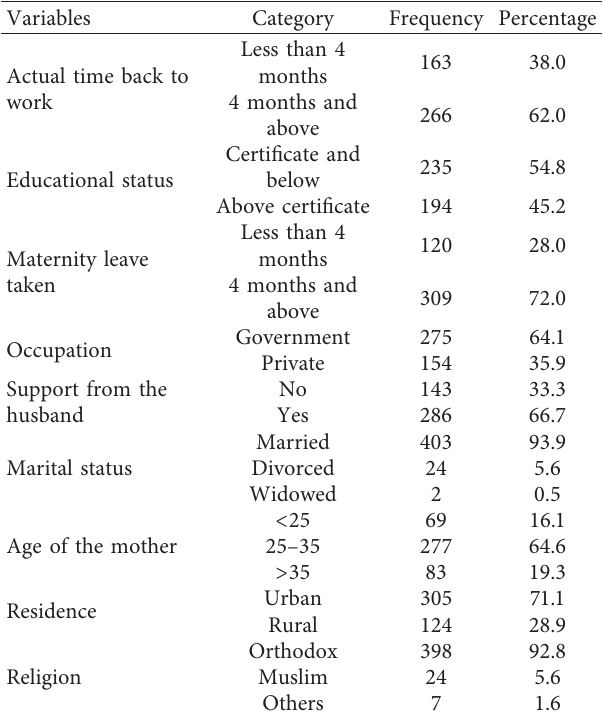
Table 1: Sociodemographic characteristics and related